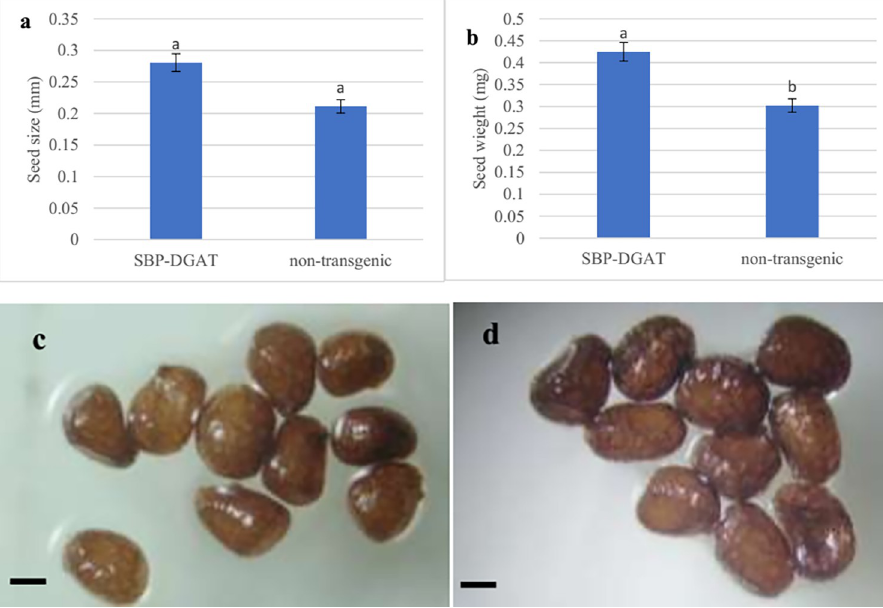
Fig 10. Functional impact of SBP promoter in size and weight of transgenic seeds: a. seed size (mm) and b. seed weight (mg). Seed’s size in c. non-transgenic and d. SBP-DGAT1 plants. Bars = 1mm. Mean values with different letters are significantly different by one-way ANOVA (P < 0.01), n =